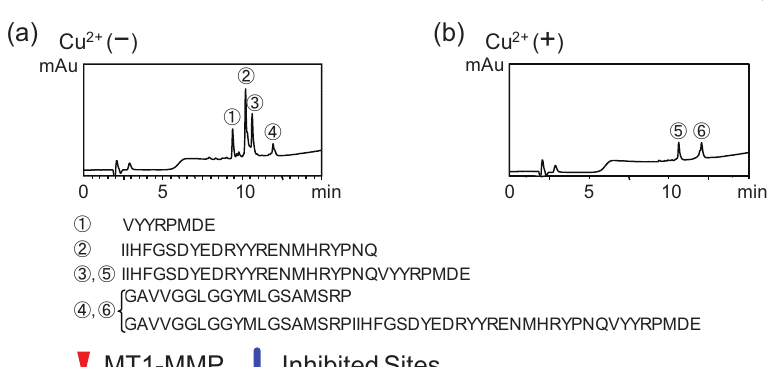
Figure 2. Determination of the cleavage sites on hPrP119–168 by MT1-MMP, and inhibitory effects of Cu 2+ . Reversed-phase HPLC revealed four peaks (Peaks-1 to -4) and two peaks (Peaks-5 and -6), respectively, from reaction mixtures in the absence ( a ) and presence ( b ) of Cu 2+ . Sequence analysis of each peak was performed by direct-injection ESI-MS.